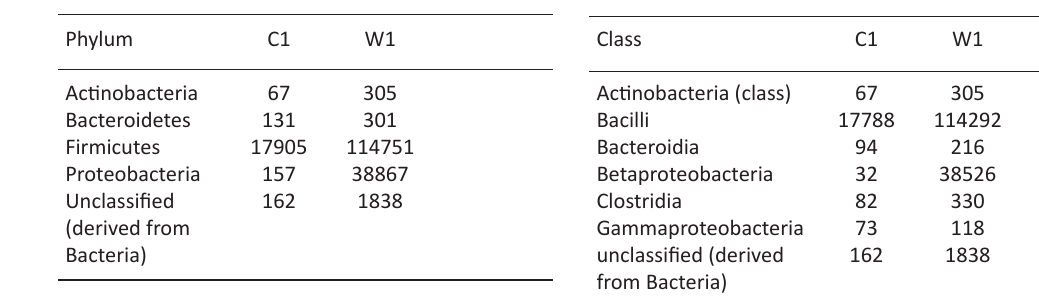
Table 5. Taxa Statistics at Class level Table 4. Taxa Statistics at Phylum level